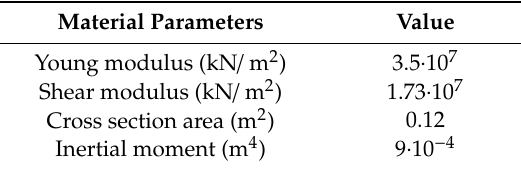
Table 5. Material parameters (structure).